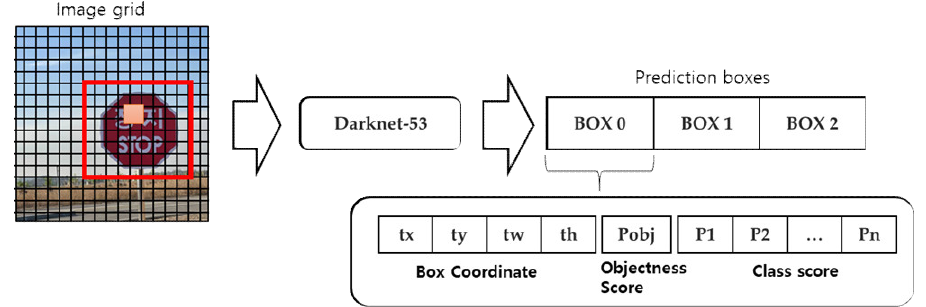
Figure 15. YOLOv3 detection and prediction feature map. Table 5. Feature extraction network of YOLOv3